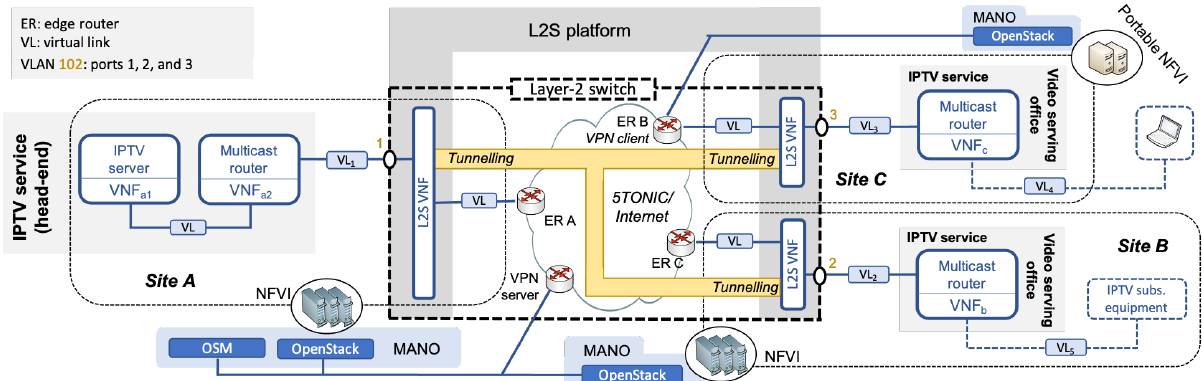
Figure 6. Overview of the validation